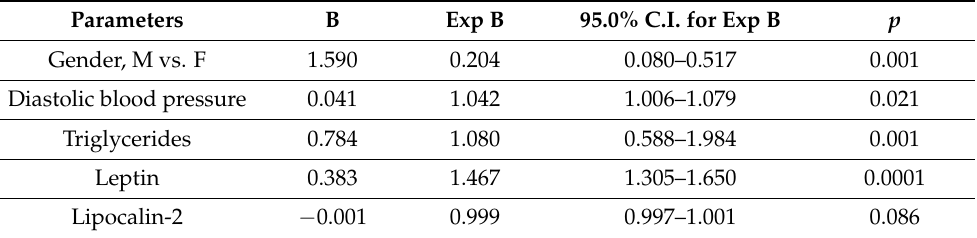
Table 4. Results of a step-by-step regression analysis of the association of adipokines/cytokines with the presence of AO against a background of hyper-LDL-C in people aged 25–44 years.